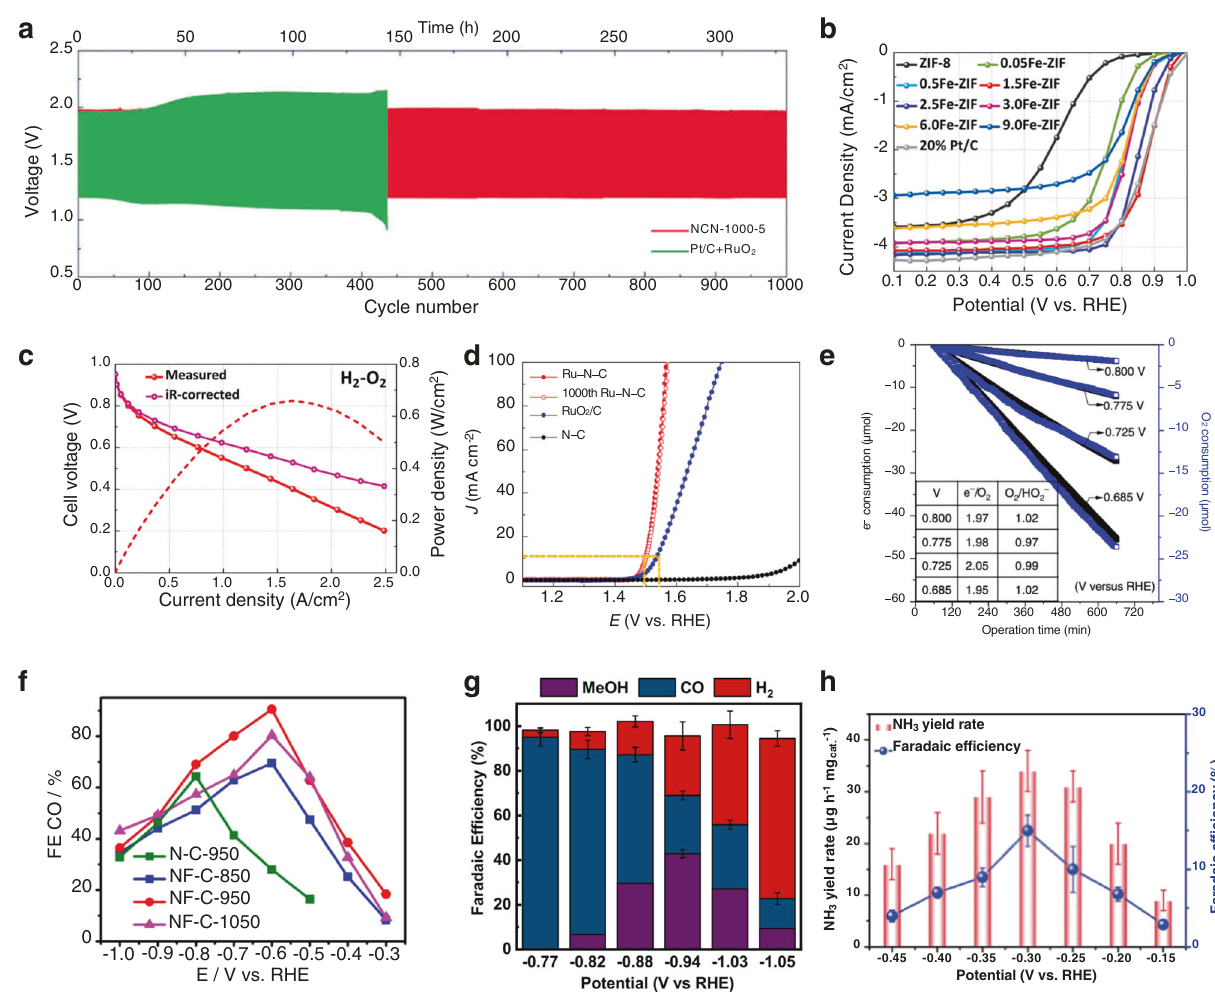
Fig. 2 Electrochemical data from EN. a Galvanostatic charge/discharge cycling curves of a Zn-air battery with N-doped graphene nanosheets (red) and a Pt/C + RuO 2 (green) cathode. Adapted and reprinted with permission from ref. 22 . b RRDE polarization plots for an Fe-based SAC (red trace) where the ORR E 1/2 was measured to be 0.88 V vs. RHE as compared to a Pt/C reference (gray trace) with E 1/2 of 0.87 V vs. RHE. Adapted and reprinted with permission from ref. 27 . c Hydrogen fuel cell performance with the same Fe-based SAC where a current density of 145 mA/cm 2 was achieved at 0.8 V vs. RHE. Adapted and reprinted with permission from ref. 27 . d Electrocatalytic OER performance for a Ru-SAC (red trace) compared with commercial RuO 2 /C reference (blue trace) in 0.5 M H 2 SO 4 . Adapted and reprinted with permission from ref. 1 . e Chronoamperometry measurements toward the 2e − ORR for a reduced graphene oxide electrocatalyst. The inset table shows the e − /O 2 and O 2 /HO 2 − measured at various potentials. Adapted and reprinted with permission from ref. 34 . f FE CO values measured at various overpotentials for an N and F co-doped EN (red trace). Adapted and reprinted with permission from ref. 41 . Copyright 2019 American Chemical Society. g Potential dependence of FE values toward the formation of MeOH, CO, and H 2 for the CO 2 RR and HER catalyzed by CoPC/CNT hybrid. Error bars represent one standard deviation from three measurements. Reprinted with permission from ref. 9 . h Yield rates and FE values for production of NH 3 by a Mo-based SAC. Error bars represent one standard deviation from six measurements. Adapted and reprinted with permission from ref. 10